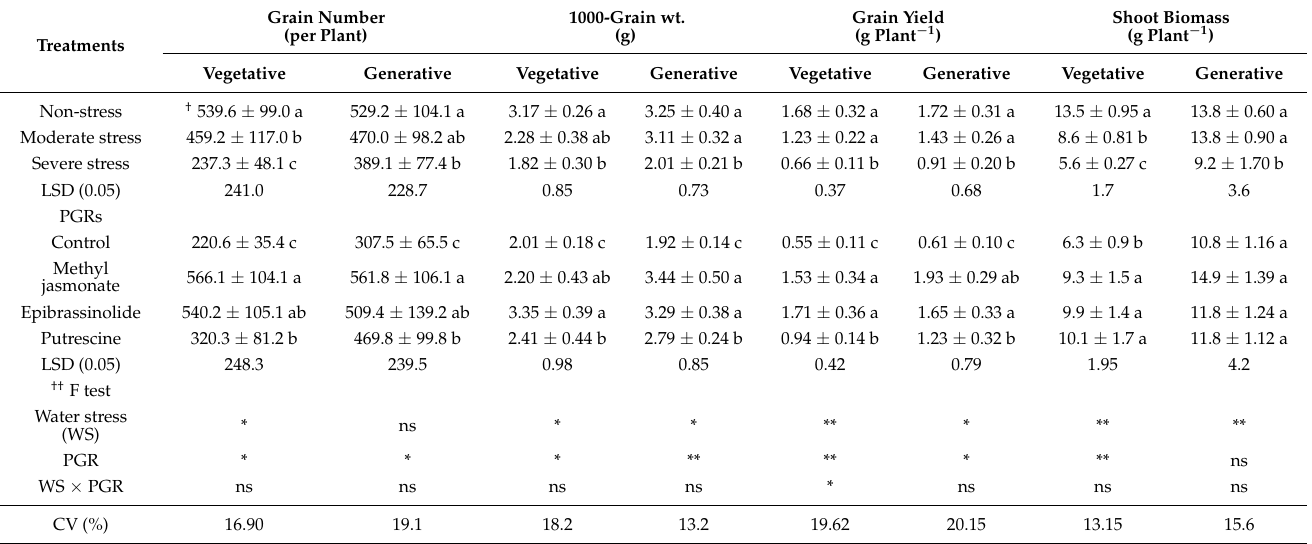
Table 2. Influence of water stress and PGRs application on grain yield and selected yield components of fennel ( Foeniculum vulgare Mill.) at two stages of